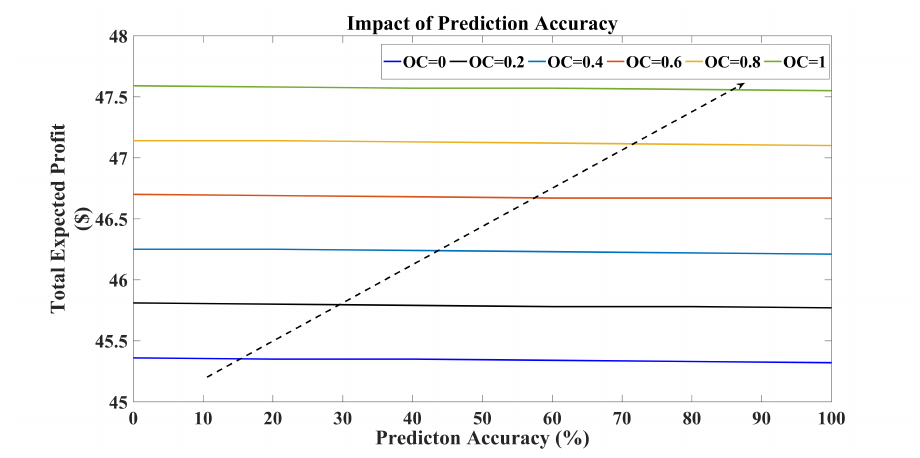
Figure 2. Impact of prediction accuracy on the total expected profit of the system. OC, Optimistic Coefficient.